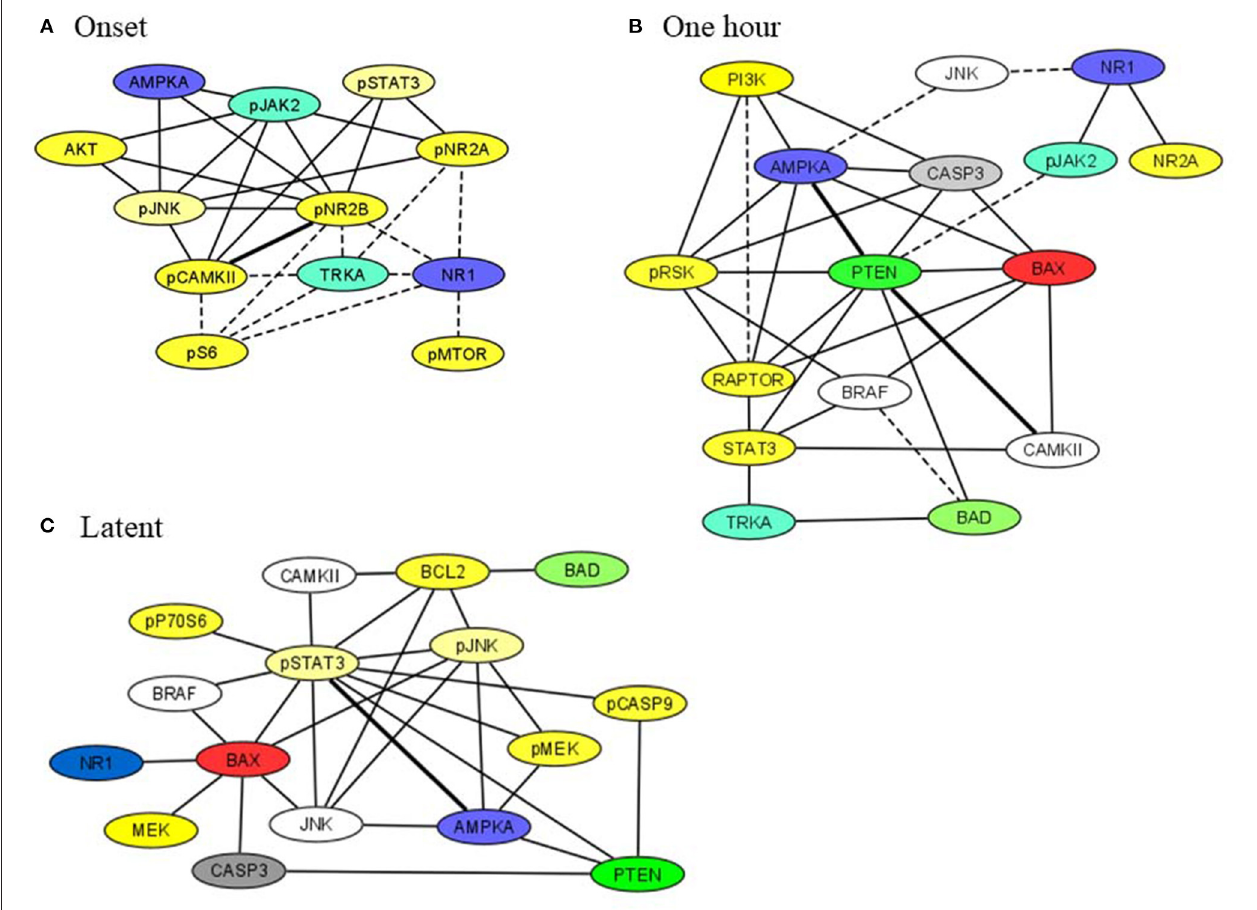
FIGURE 4 | Correlation networks in hippocampus including STAT3, JAK2, and NMDAR subunits at (A) onset, (B) 1h, (C) latent period. Correlations between protein levels were determined by Spearman Correlation analysis; only correlations with r > 0.8, with linear scatter plots and p < 0.05 were considered significant and are included. Heavy solid lines, correlations seen in pilocarpine and saline treated mice; thin solid lines, correlations seen only in pilocarpine treated mice; dashed lines, correlations seen only in saline treated mice. Colors indicate proteins present in two or three